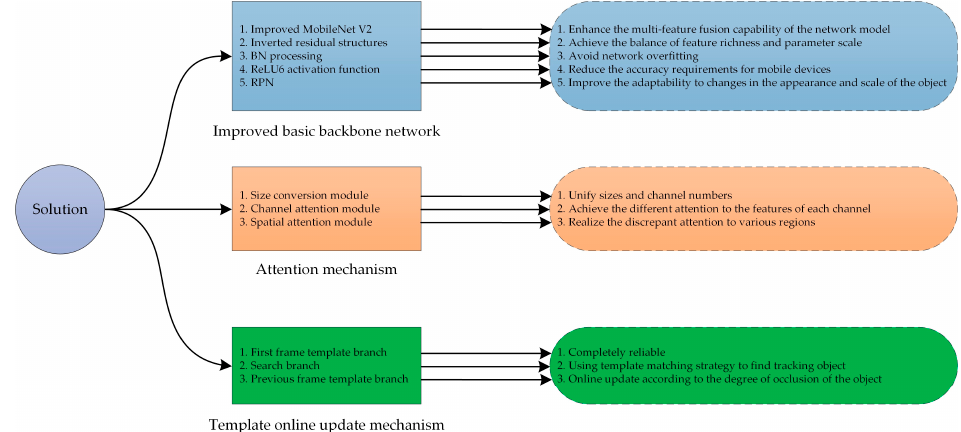
Figure 2. The building blocks of the double-template Siamese network model based on multi-feature fusion.